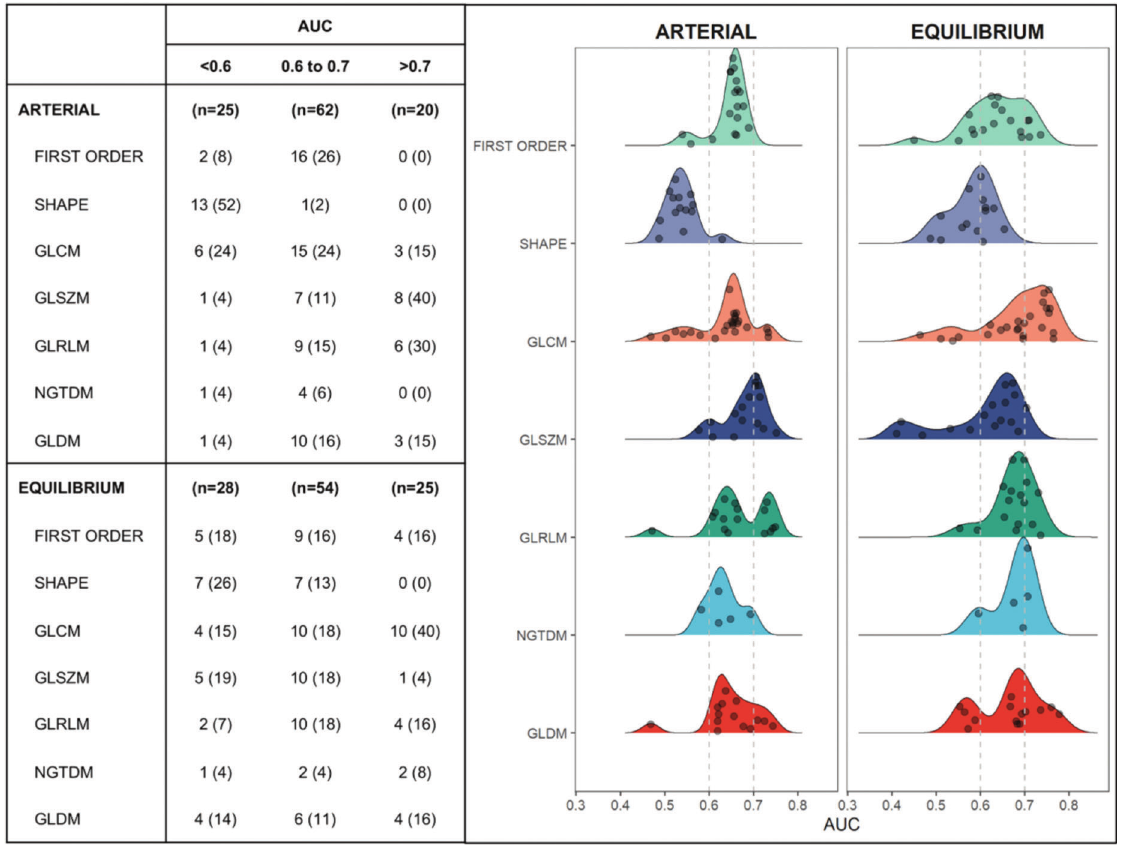
Figure 3 - Discriminatory performance of textural features extracted from arterial and equilibrium phases of pre-treatment MRI grouped according to their area under the curve. GLCM (Gray Level Co-occurrence Matrix), GLSZM (Gray Level Size Zone Matrix), GLRLM (Gray Level Run Length Matrix), NGTDM (Neighboring Gray Tone Difference Matrix), and GLDM (Gray Level Dependence Matrix) are second order textural